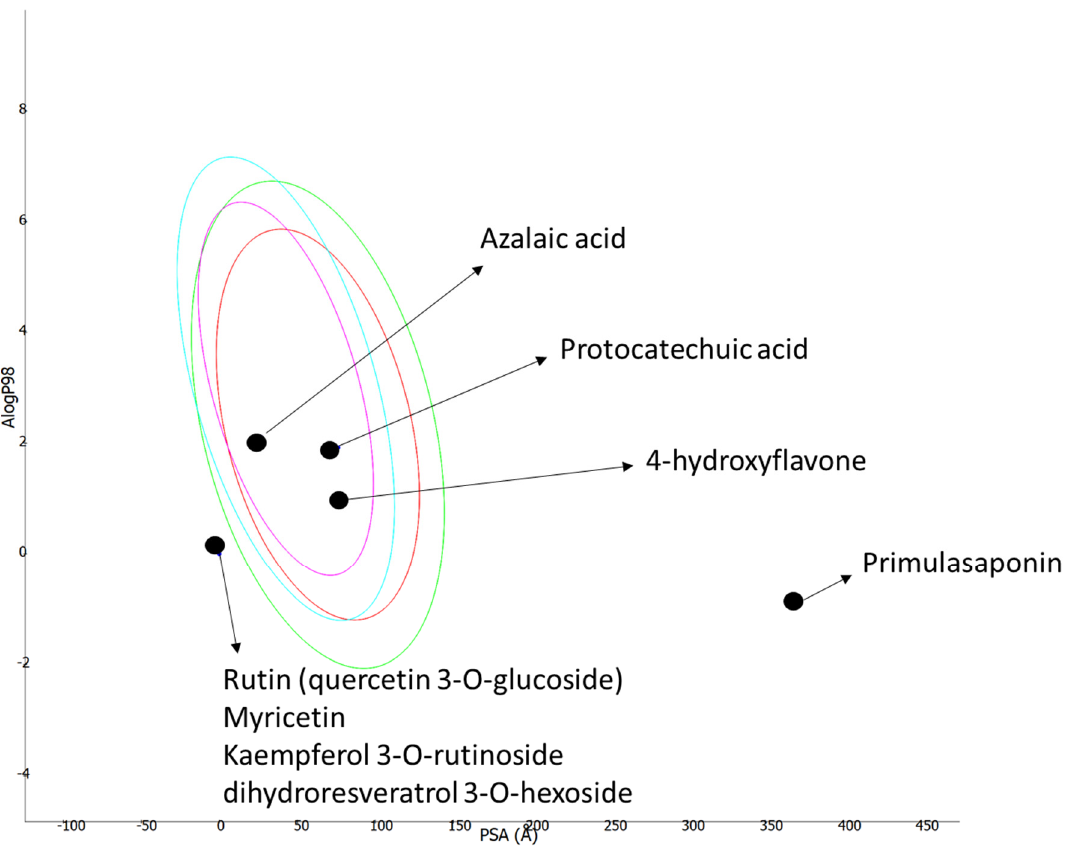
Figure 3. Logarithm of octanol–water partition coefficient (LogP) versus topological surface area (PSA). The four ellipses define area well-absorbed molecules are expected to fall. A total of 95 and 99% of a compound should be in ellipses colored in red and green, respectively. For the blood–brain barrier penetration, 95 and 99% of a compound should be located within the ellipses colored with magenta and aqua, respectively.